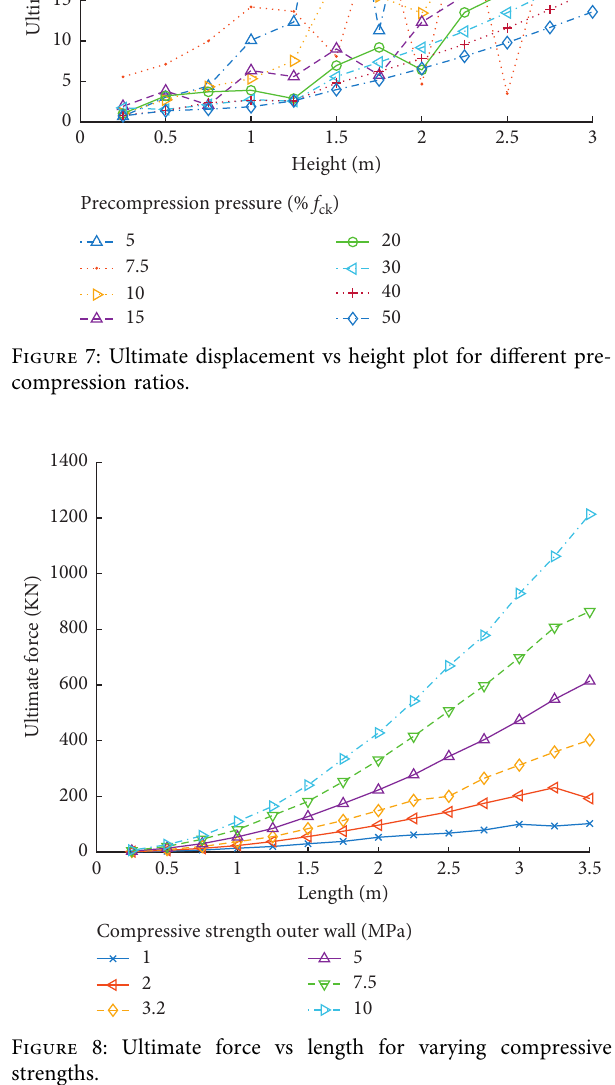
Figure 6: Yield displacement vs height plot for different pre- compression ratios.